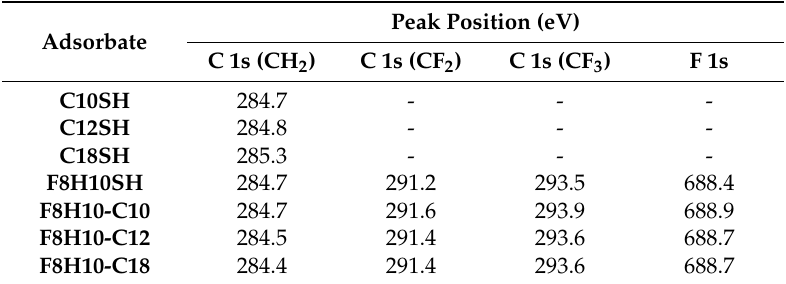
Figure 4. XPS spectra of the C 1s region collected from SAMs derived from the normal alkanethiols, C10SH , C12SH , and C18SH . Table 3. XPS peak positions for the C 1s and F 1s regions for the partially fluorinated SAMs.